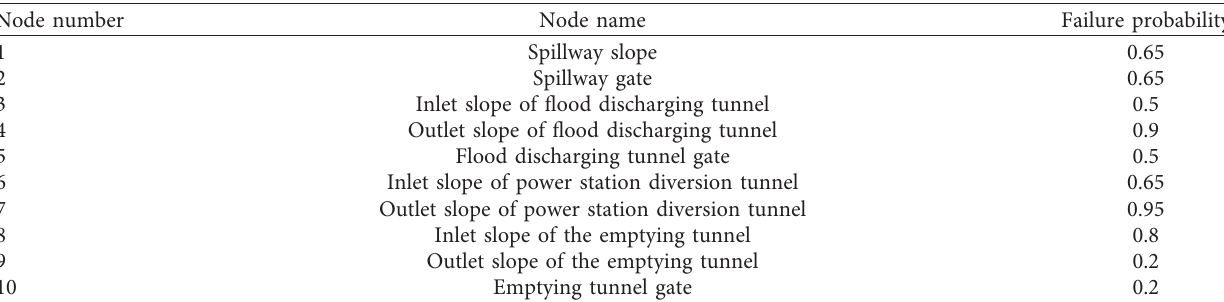
Table 4: Probabilities of seismic landslides and gate failures.